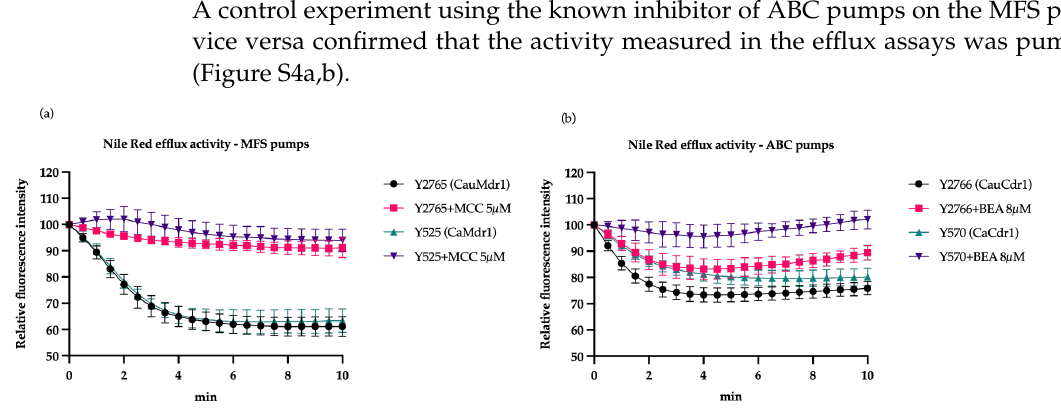
Figure 2. Nile Red efflux activity of recombinant fungal efflux pumps ( a ) MFS and ( b ) ABC pumps. Strains starved in the presence of 5 mM 2-DOG for 30 min were loaded with 7.5 µM Nile Red. Efflux was initiated with 20 mM glucose. As Nile Red is less fluorescent in aqueous solution than when cell bound, the fluorescence signal decreases when it has been effluxed from the cell [53] . All strains exhibited a decrease in fluorescence intensity over a period of 10 min after glucose addition. The pump-specific inhibitors not only reduced the initial rates of efflux but also the steady-state levels of Nile Red associated with the cells were maintained or returned to near-control levels. The percent mean relative fluorescence intensity for three biological replicates ( n = 3) is shown, with each assay carried out using duplicates. The bars represent the standard deviation. MCC = MCC1189, BEA = Beauvericin.